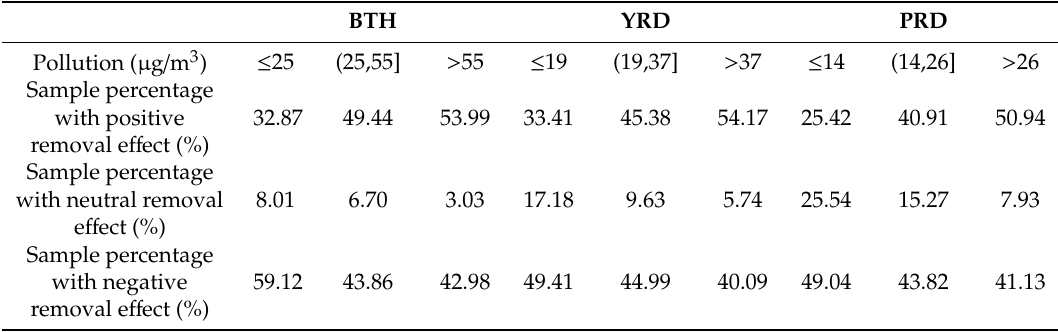
Table 2. Sample percentage with positive, neutral, and negative removal e ff ect for three equal-sample bins of pollution levels in the BTH, YRD, and PRD